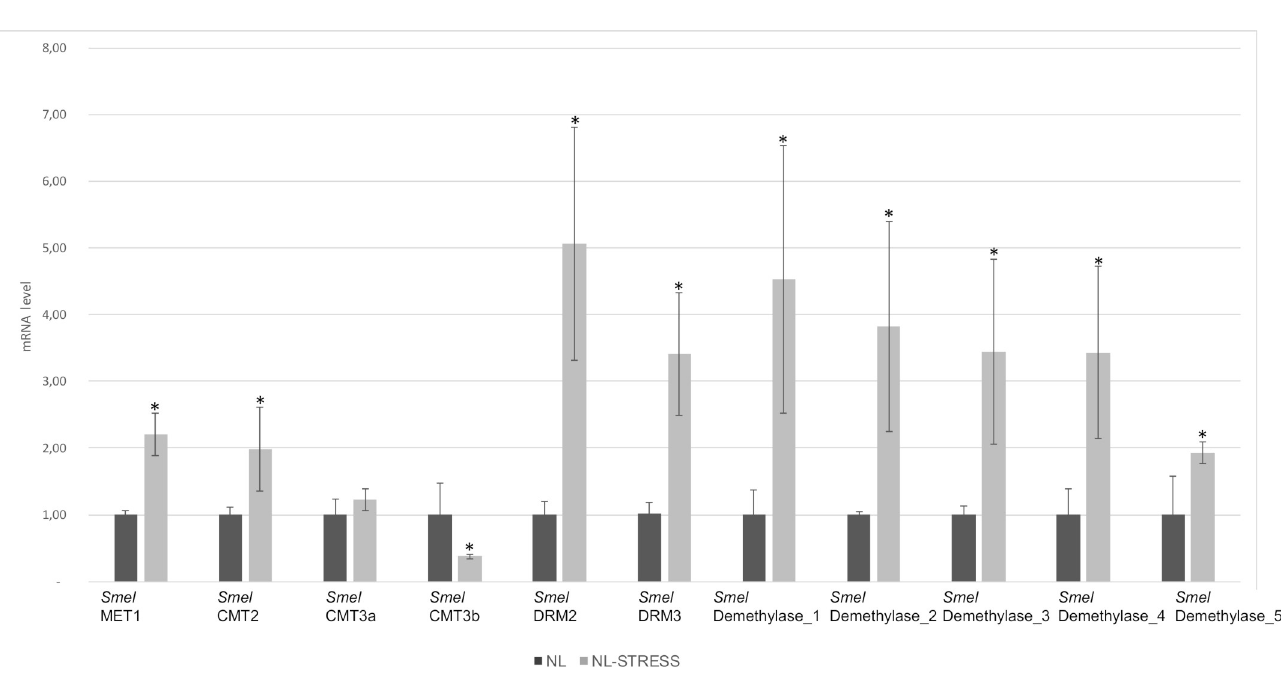
PLOS ONE | https://doi.org/10.1371/journal.pone.0223581 October 9, 2019 11 /